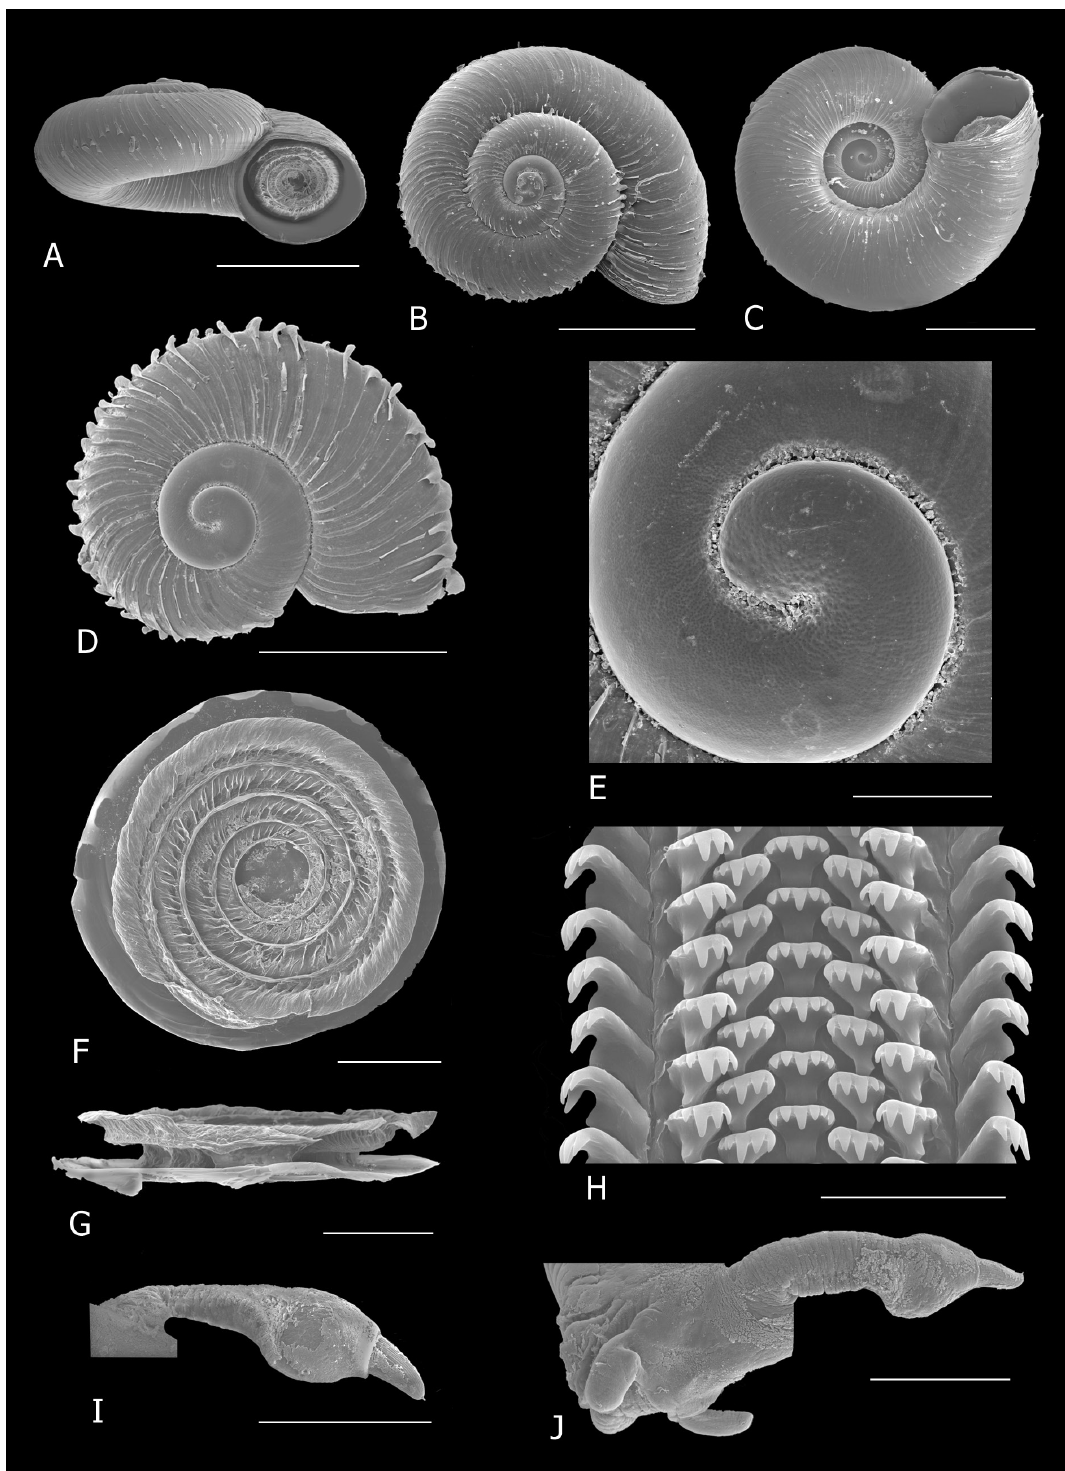
Fig. 18. Chondrocyclus devilliersi sp. nov. A . Aperture view (ELM W3962/T174). B . Dorsal view (ELM W3962/T174). C . Ventral view (ELM W3962/T174). D . Dorsal view of juvenile shell (NMSA V9111/ T4110). E . Protoconch (NMSA V9111/T4110). F–G . Operculum (ELM W3962/T174). H . Portion of radula (ELM W3962/T174). I . Penis, lateral view (ELM W3962/T174). J . Penis, dorsal view ((ELM W3962/T174). Scale bars: A–C = 2 mm; D, I–J = 1 mm; E = 200 µm; F–G = 500 µm; H = 50